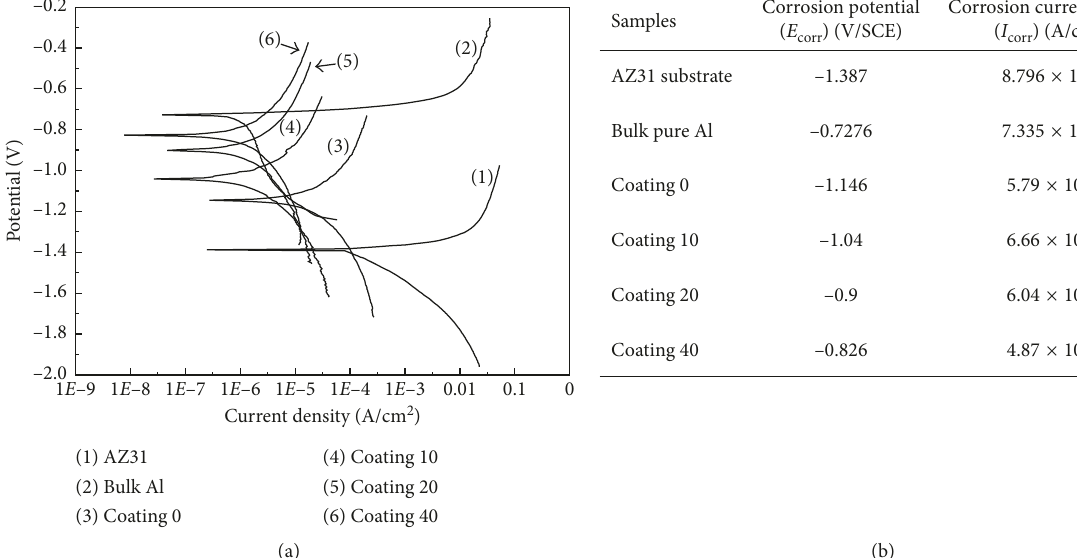
Figure 6: Potentiodynamic polarization curves and electrochemical characteristics of the substrates and the